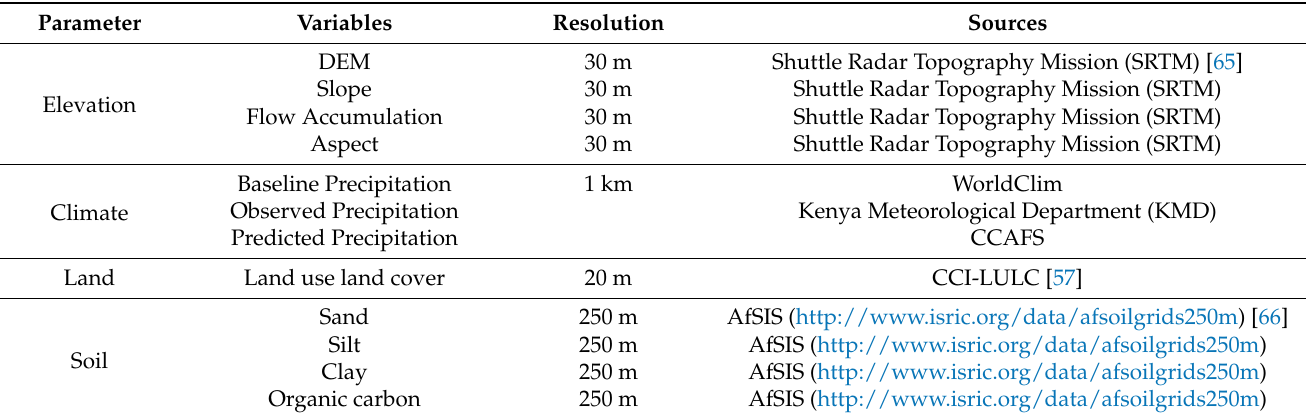
Table 2. Data sources for the different datasets applied in this